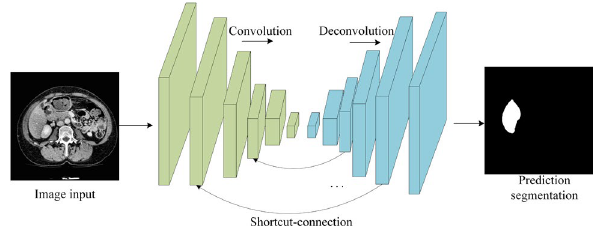
Fig. 1 Basic structure of FCN segmentation network